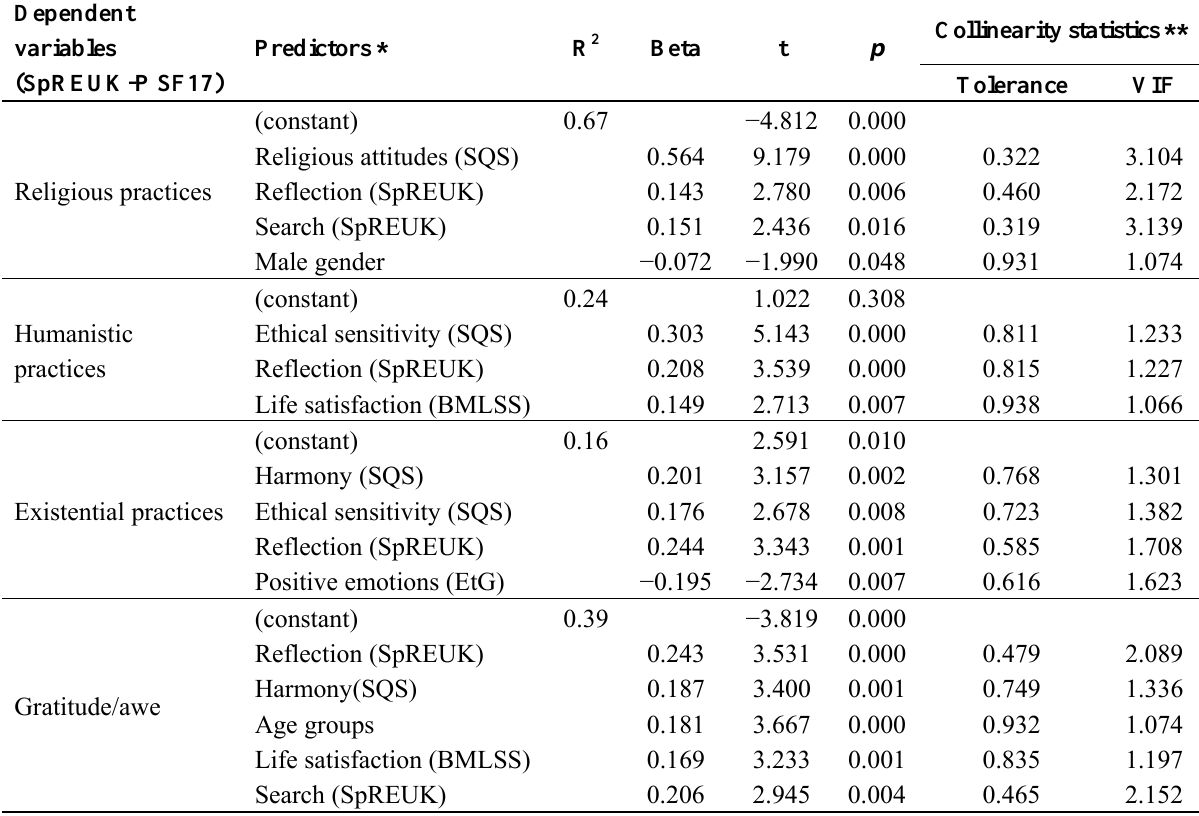
Table 5. Predictors of patients’ engagement in spiritual practices (stepwise regression